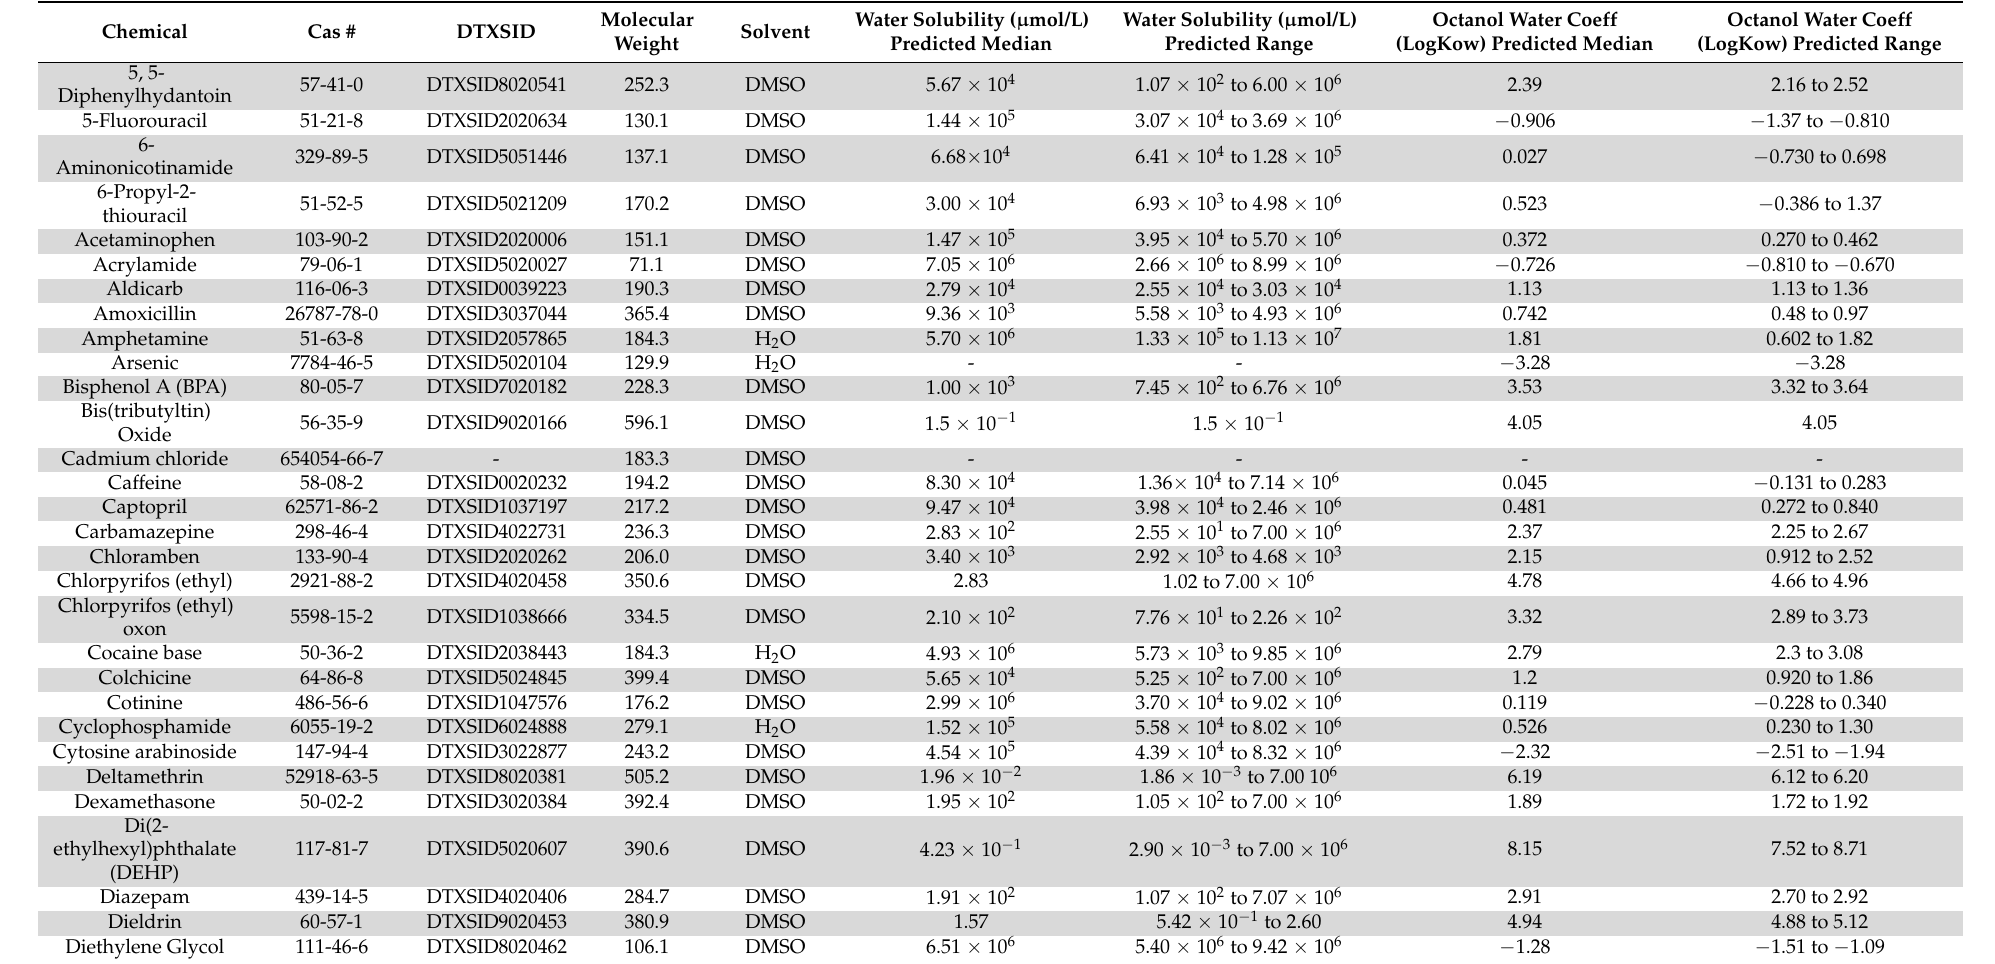
Table 1. List of Chemicals Tested . Each chemical is listed by row. The columns (from left to right) contain the following information on a given chemical: name; CAS number; DTXSID, molecular weight; solvent in which the chemical was dissolved; predicted median and range of water solubility; and predicted median and range of the octanol/water partition coefficient. Values obtained from https://comptox.epa.gov/dashboard/ Last Accessed: 25 January